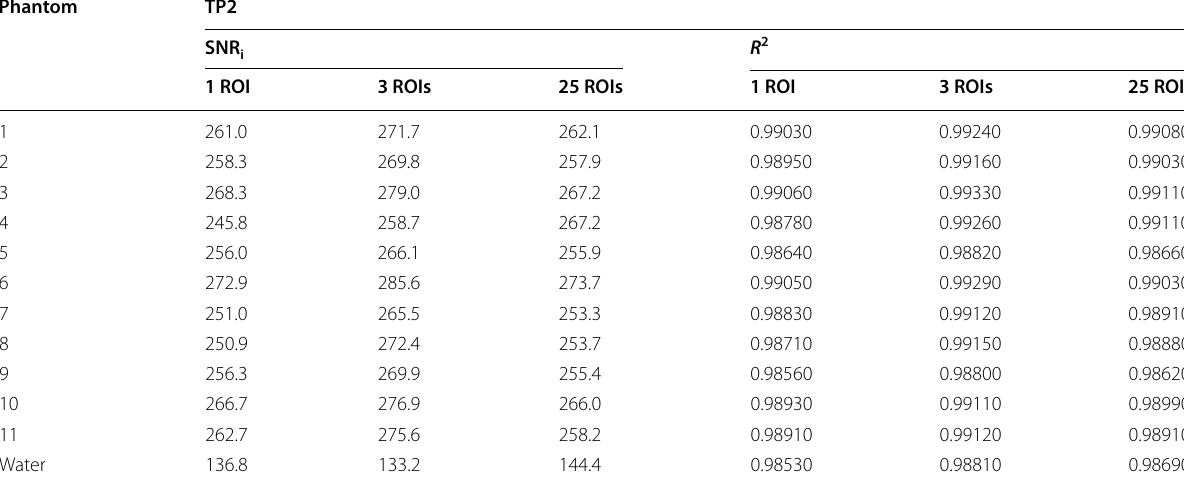
Table 5 SNR and R 2 values of agar gel and water phantoms for T2 curves at TP2 i Phantom